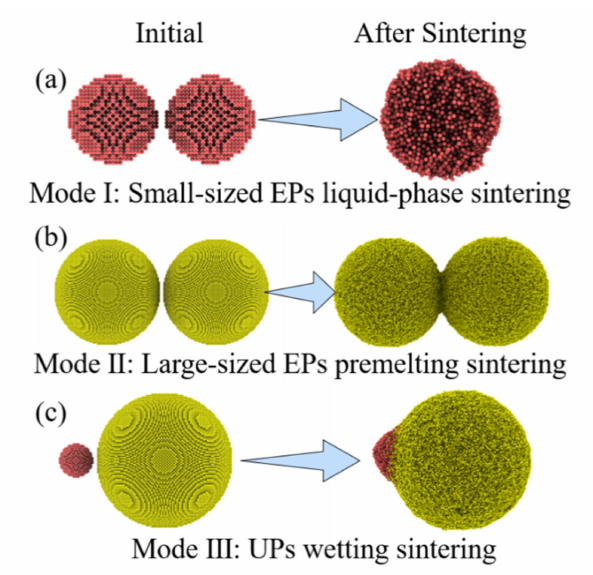
Figure 16. ( a – c ) Three basic sintering modes during the MP sintering